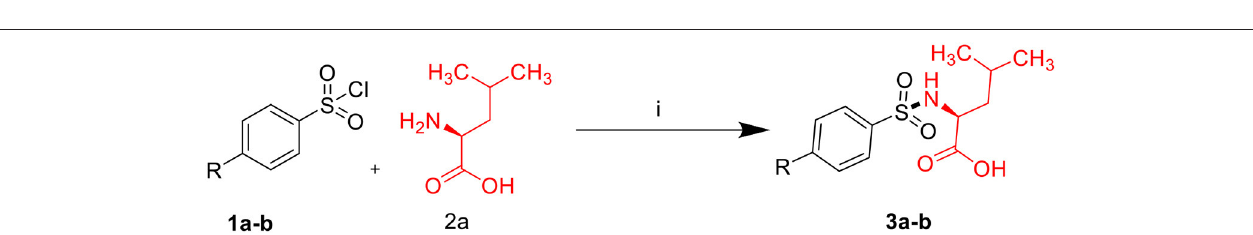
SCHEME 1 | Synthesis of compounds (3a–b).